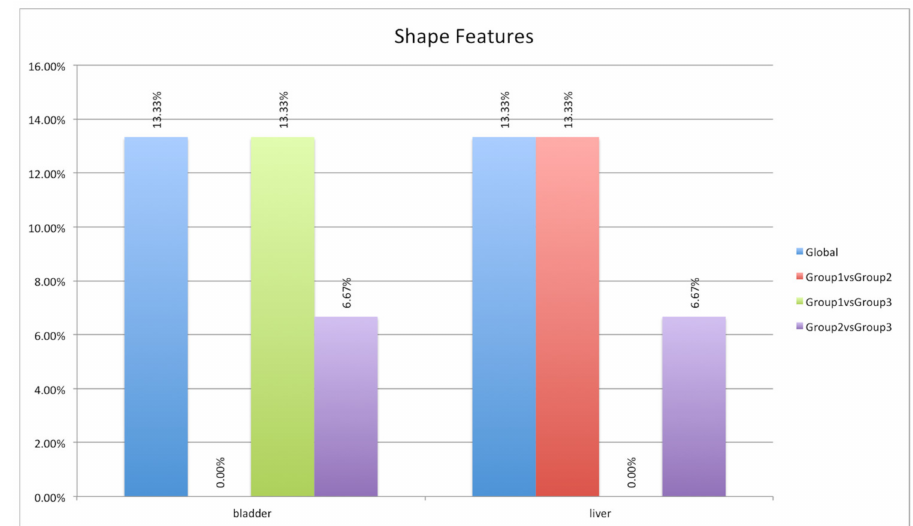
Figure 7. ANOVA and HSD test analyses showing differences in the shape feature group (15 features) in the three mouse groups (blue column) and differences considering pairs of groups: first group versus second group (red column), first group versus third group (green column), and second group versus third group (violet column).